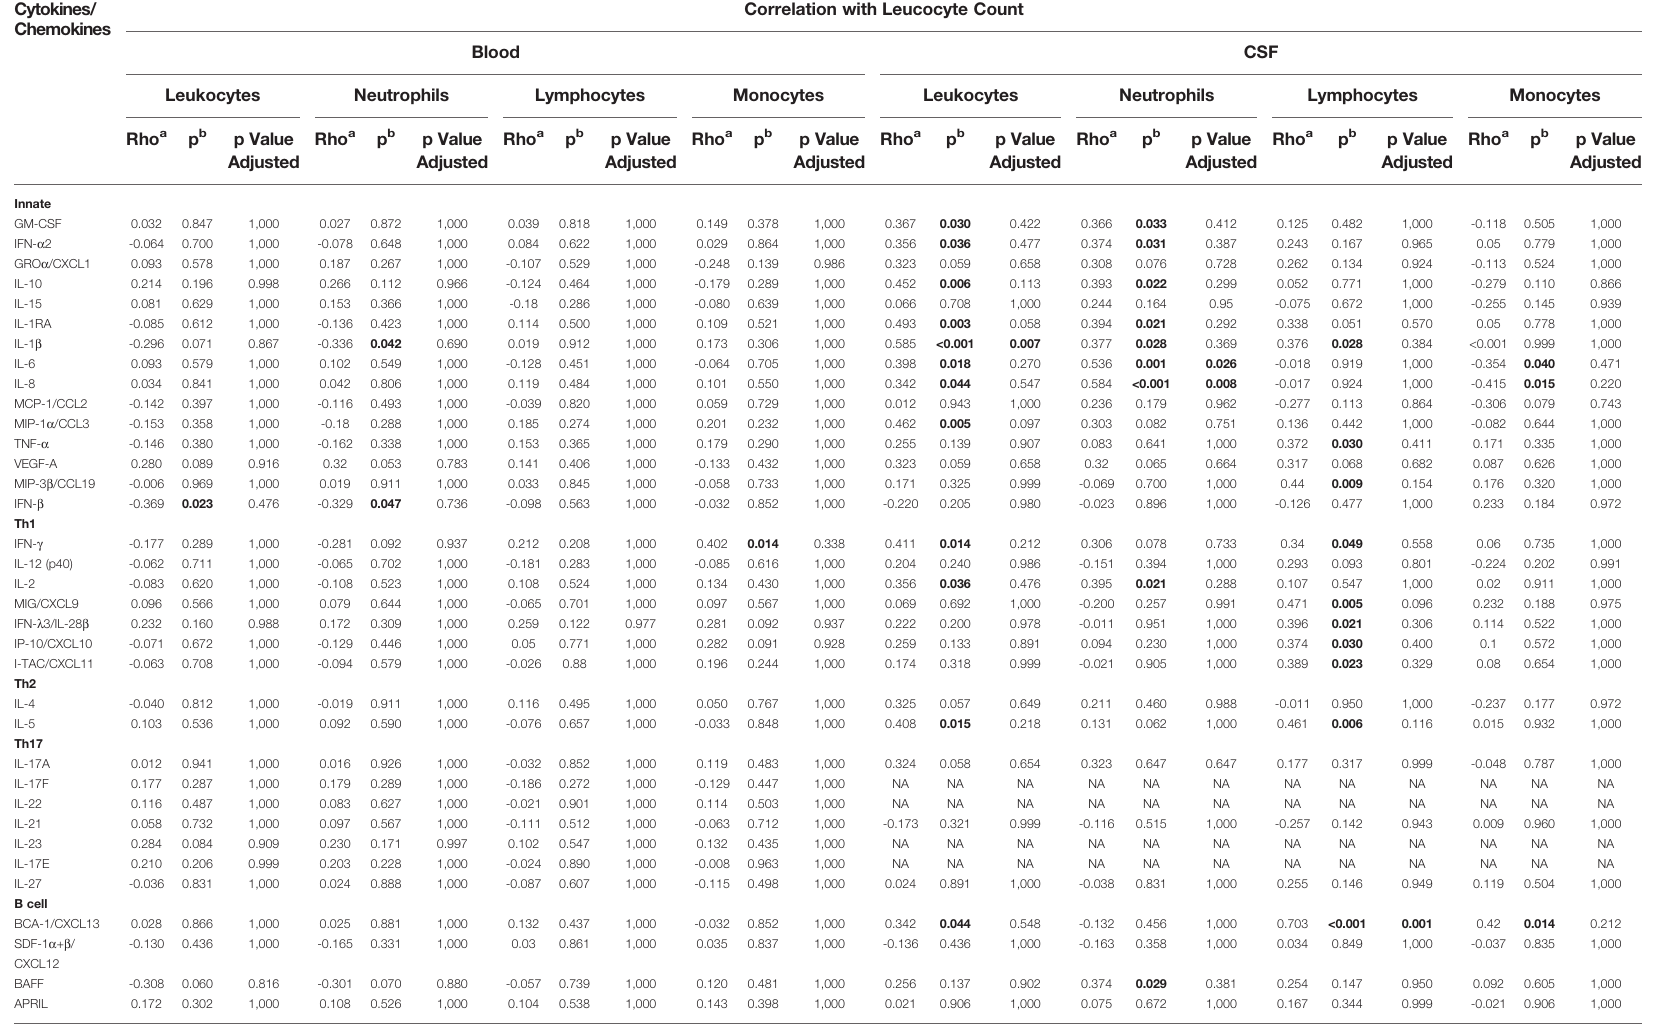
TABLE 4 | Correlation of Cytokine/Chemokine levels in serum/CSF and leukocyte count in blood/CSF at hospitalization of VBT TBE patients. Cytokines/